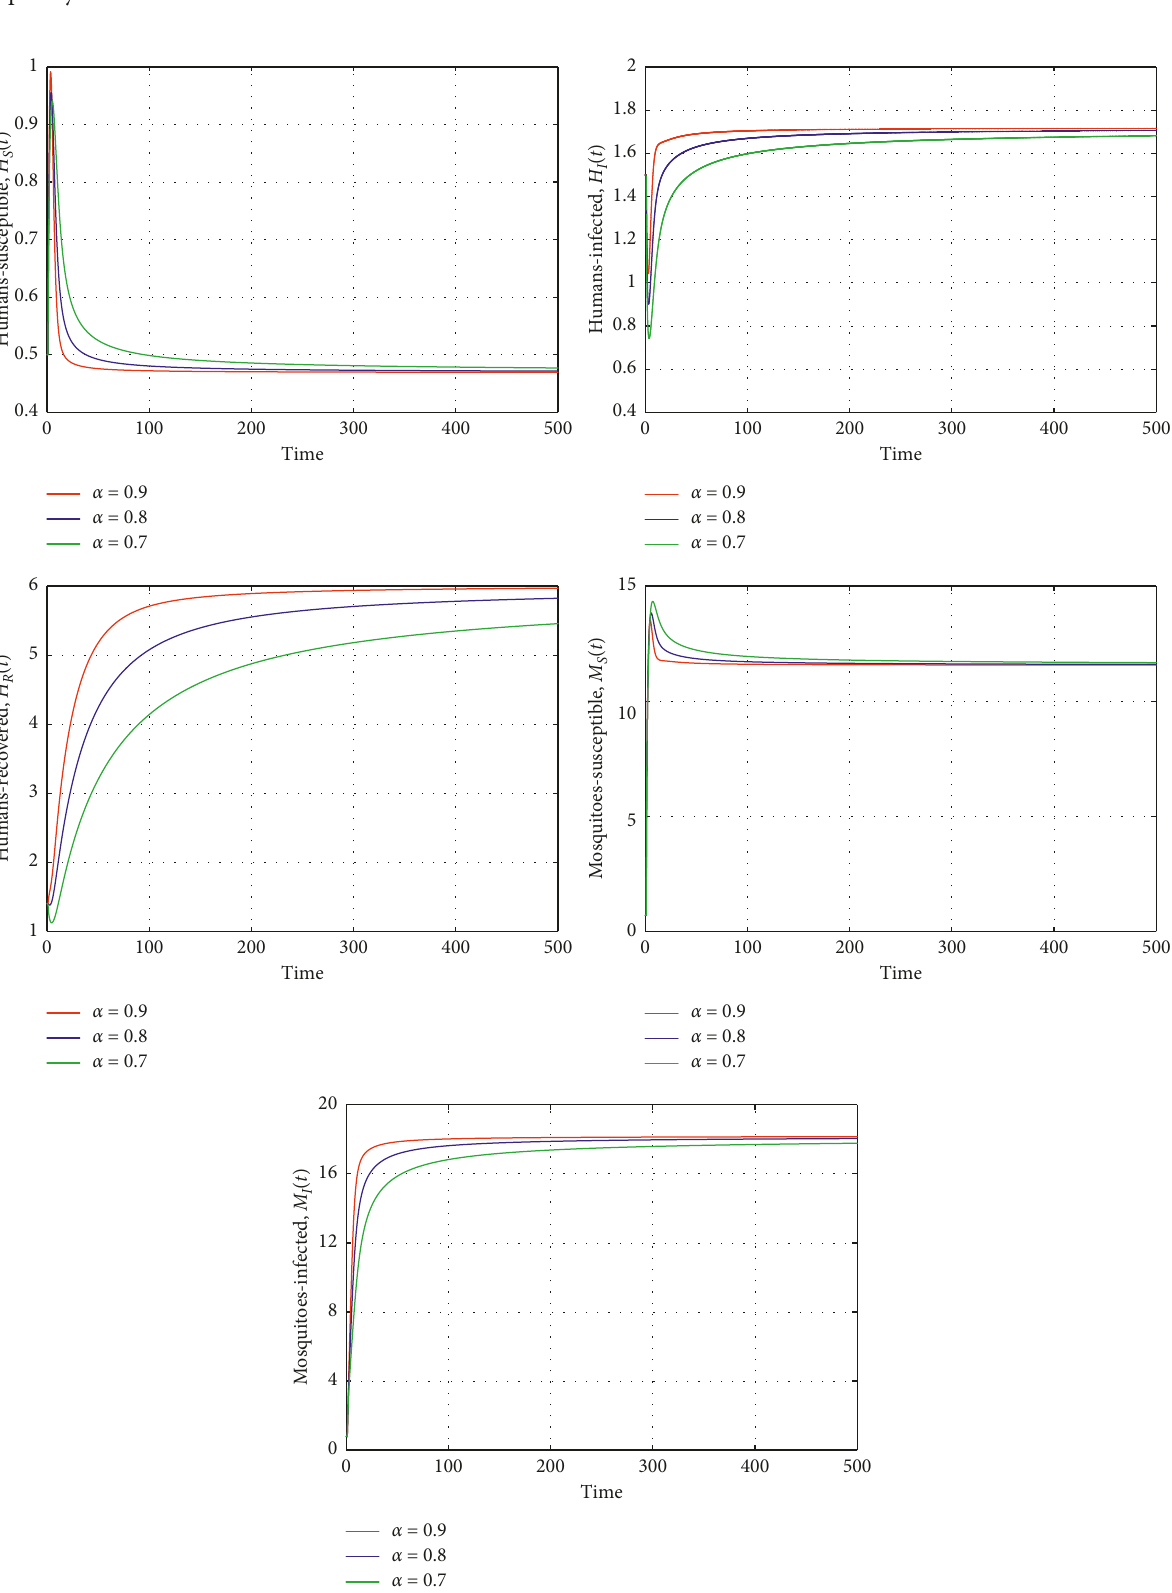
� τ � τ � 0. The steady state of the system is 1 2 3